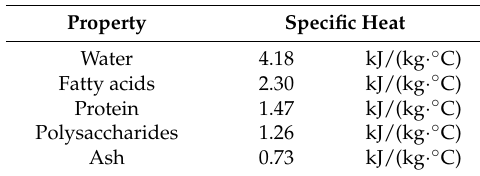
Table 6. Specific heat assumption.